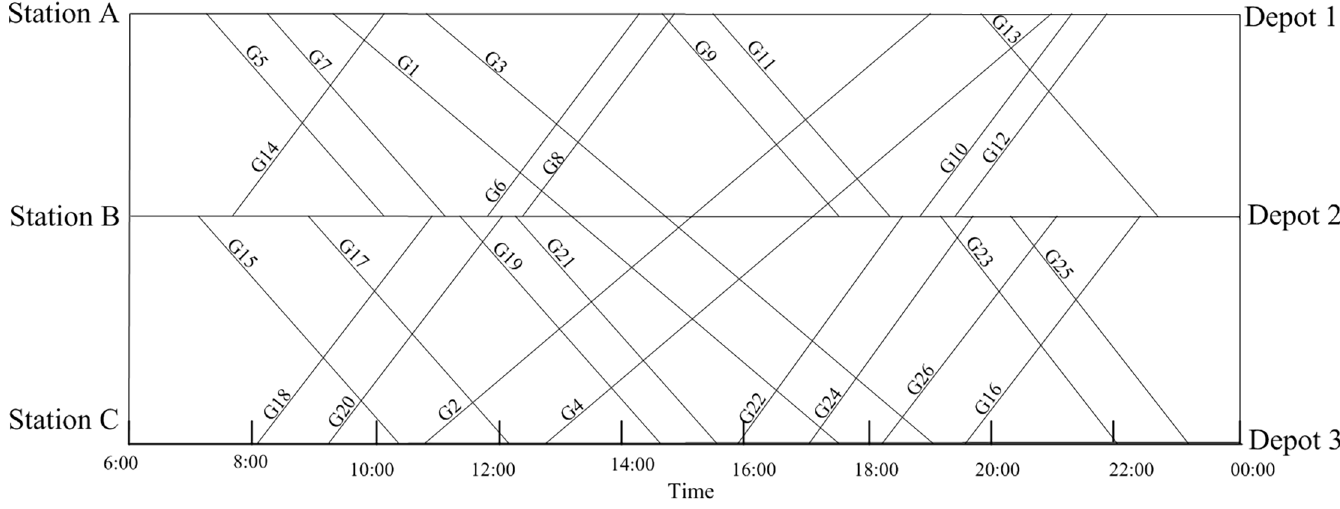
Fig 3. Train space-time diagram.